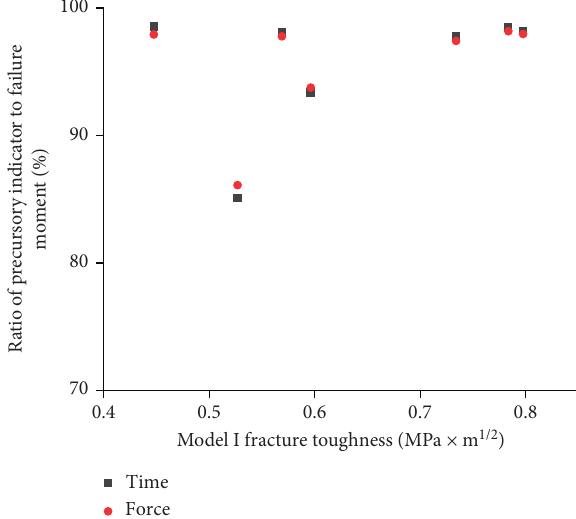
Figure 11: Scatter diagram between the ratios of the precursory indicator to failure moment and mode I fracture toughness of marble